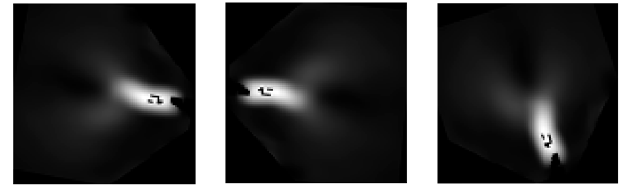
Figure 11. Rotated SDGs.